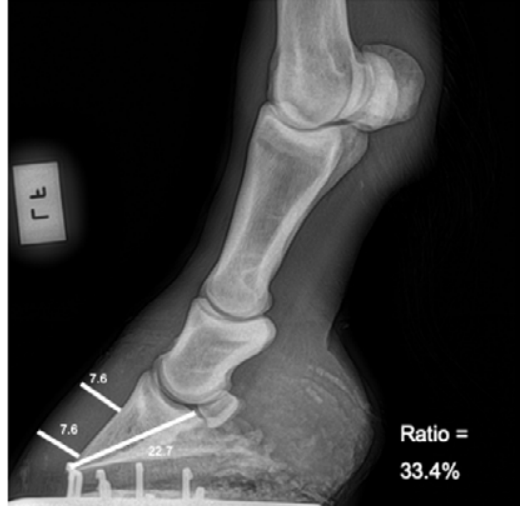
Figure 4: Lateromedial projection of the foot of a sound 14-year-old Arab gelding revealing an increased dorsal hoof wall to palmar P3 length ratio.